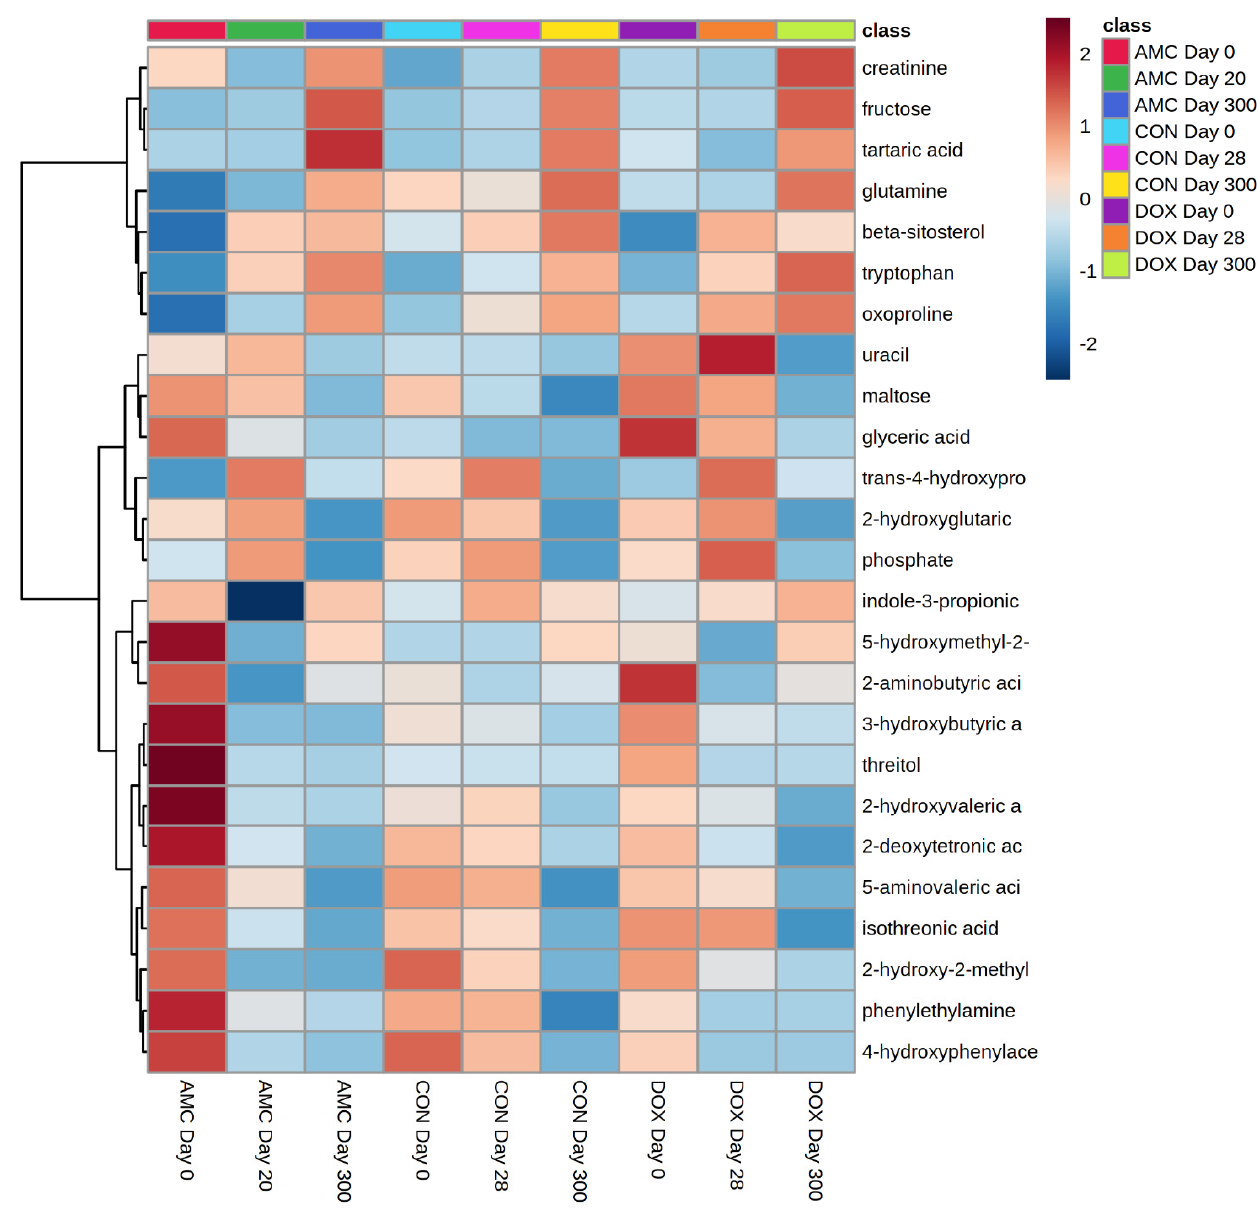
Figure 4. Changes in the abundance of serum metabolites that significantly differed between cats of the DOX and those of the CON group on day 20/28 (uracil, guanine, hypoxanthine) and from day 0 CON cats at this age. Heatmaps, which graphically represent variations in fecal metabolite to day 28 within cats of the DOX group (thymidine). Means and standard deviations are displayed. concentrations within each group of cats, are presented in Figure 9.